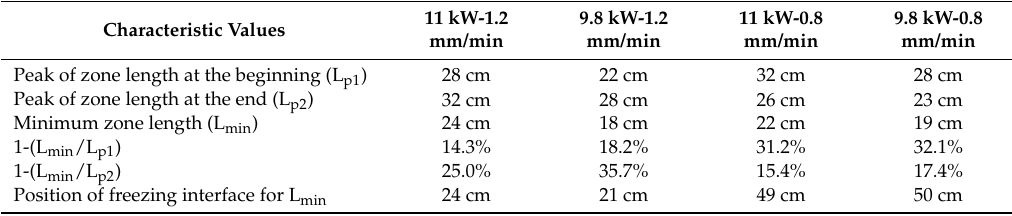
Table 2. Comparison of characteristic values of zone length variation by changing process parameters.